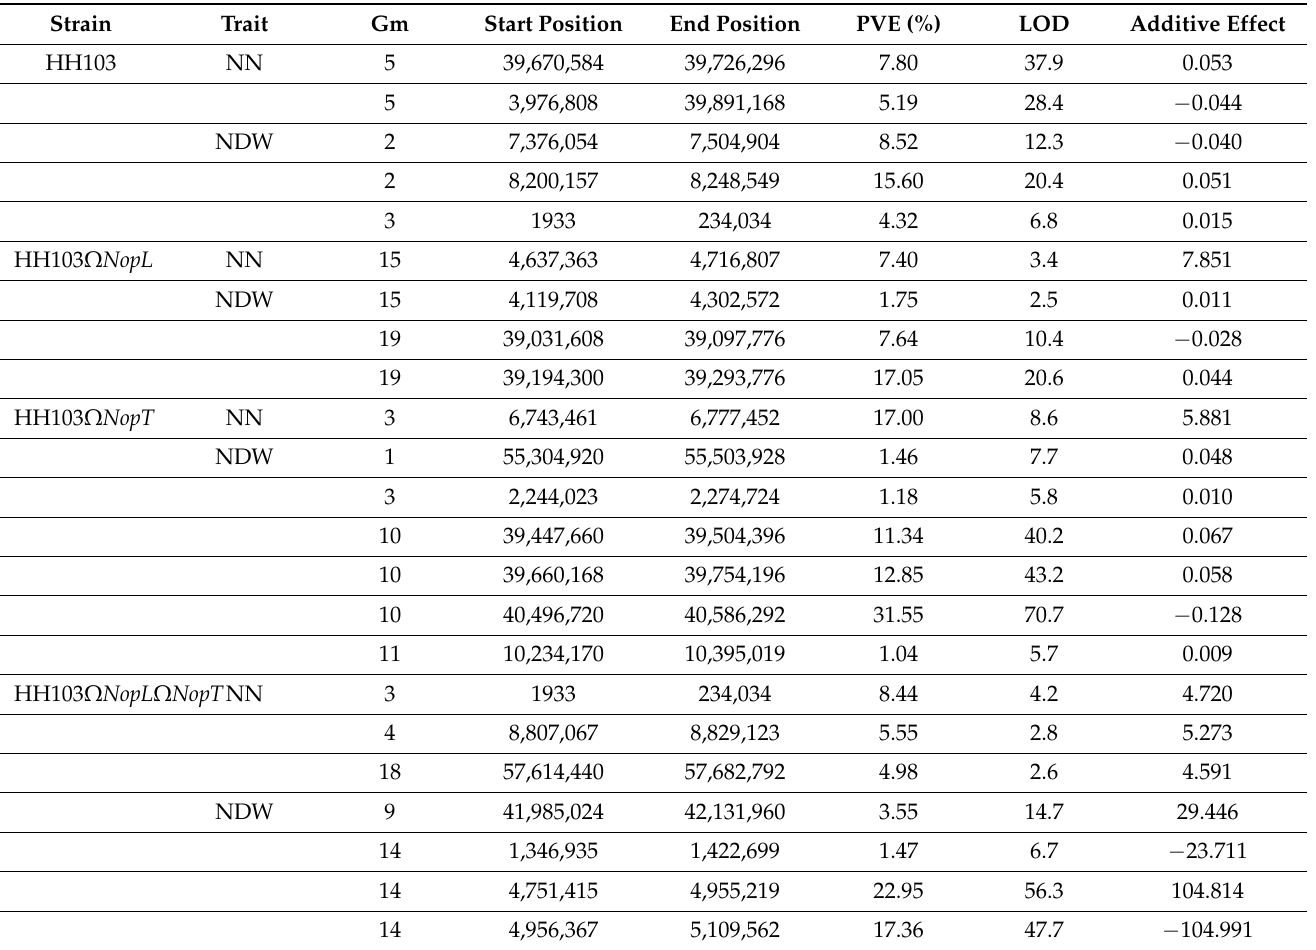
Table 2. Distribution of conditional quantitative trait locus (QTL) for nodule number (NN) and nodule dry weight (NDW) among linkage groups and